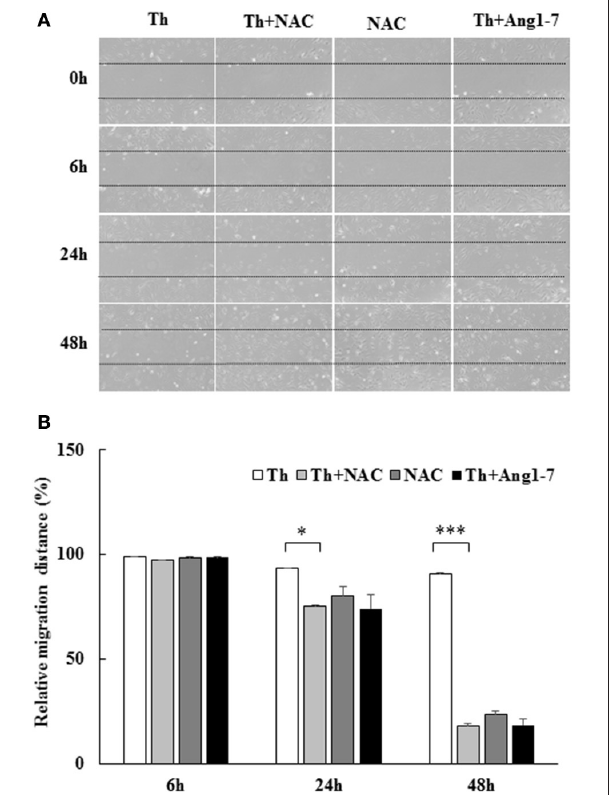
FIGURE 6 | Protective effect of angiotensin-(1-7) on thrombin-induced migration impairment is ROS-dependent. HAECs were stimulated with thrombin (2 U/mL) for 24 and 48h with or without 100nM angiotensin-(1-7) pretreatment 1h before the thrombin stimulation. Cells were pretreated with the ROS scavenger NAC at a dose of 10mM for 1h before thrombin stimulation. NAC pretreatment significantly recovered the thrombin-induced decrease in the migratory distance. n = 3, * p < 0.05 and *** p < 0.001 for thrombin compared with thrombin + NAC